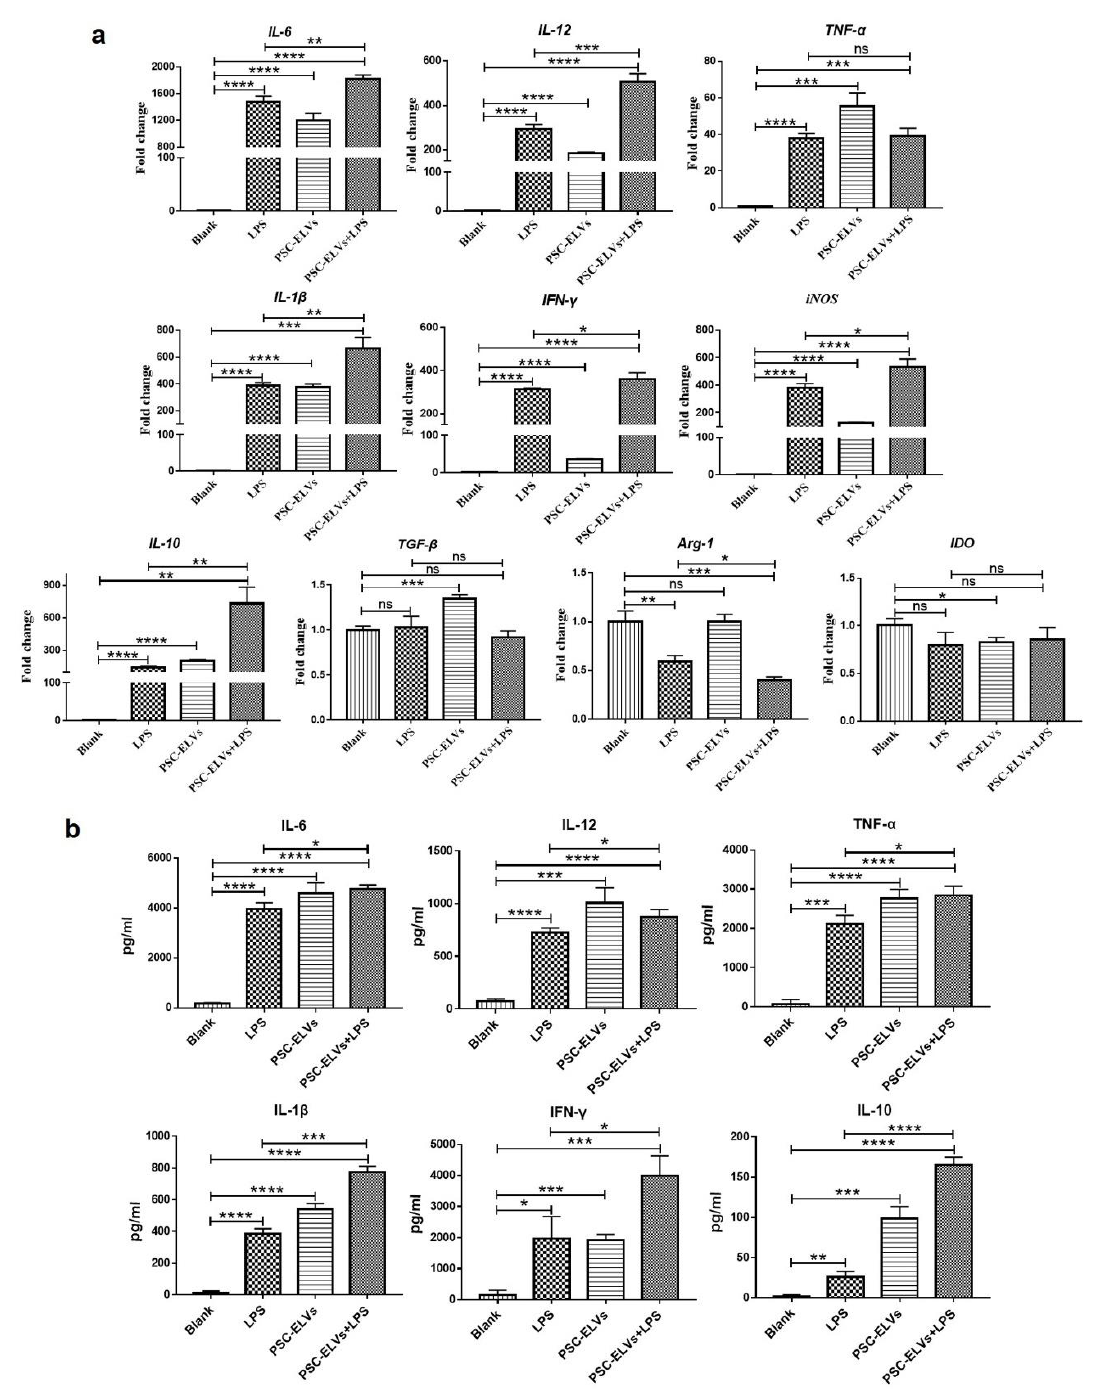
Figure 4. The expression levels of proinflammatory and anti-inflammatory factors in BMDCs stim- ulated by PSC-ELVs. ( a ) The mRNA levels of proinflammatory and anti-inflammatory factors in BMDCs stimulated with PSC-ELVs, as detected using qRT-PCR; ( b ) The protein levels of proinflam- matory and anti-inflammatory factors in BMDCs stimulated with PSC-ELVs, as detected using en- zyme-linked immunosorbent assay (ELISA). * p < 0.05; ** p < 0.01; *** p < 0.001; **** p < 0.0001; ns, not significant.